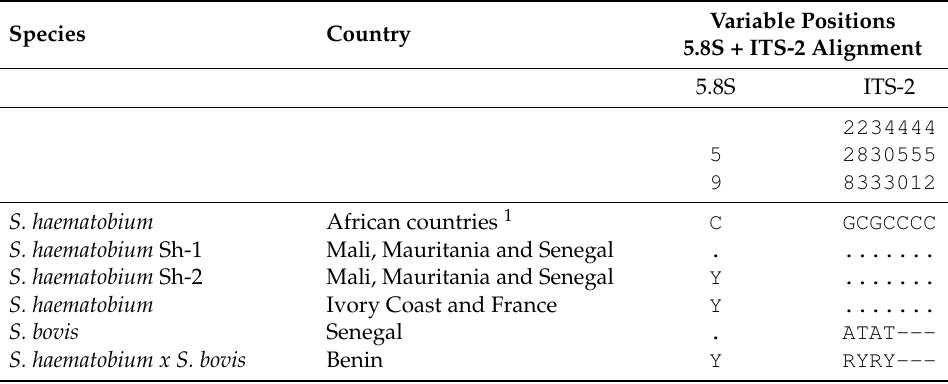
Table 2. Variable positions in the 5.8S and ITS-2 sequence alignment of Sh-1 and Sh-2 haplotypes of S. haematobium obtained in this study and other S. haematobium , S. bovis and S. haematobium x S. bovis sequences from GenBank. The numbers (to be read vertically) refer to variable positions obtained in the alignment made with MEGA X; . = identical; - = not sequenced. Heterozygotic positions are represented with the corresponding symbol of the IUPAC code for an incomplete nucleic acid specification. Species Country